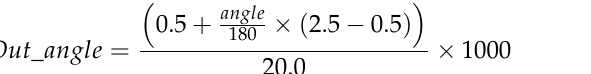
Figure 22. Control architecture for machines.